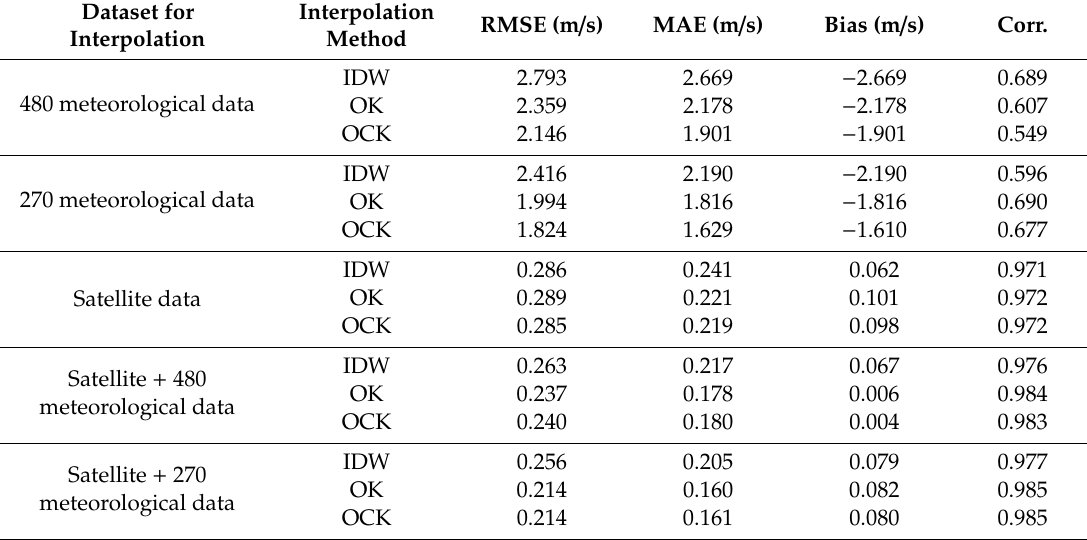
Table 4. Statistics of the comparison between buoy-derived Weibull scale parameter (C) data and interpolated Weibull C data at a height of 10 m.